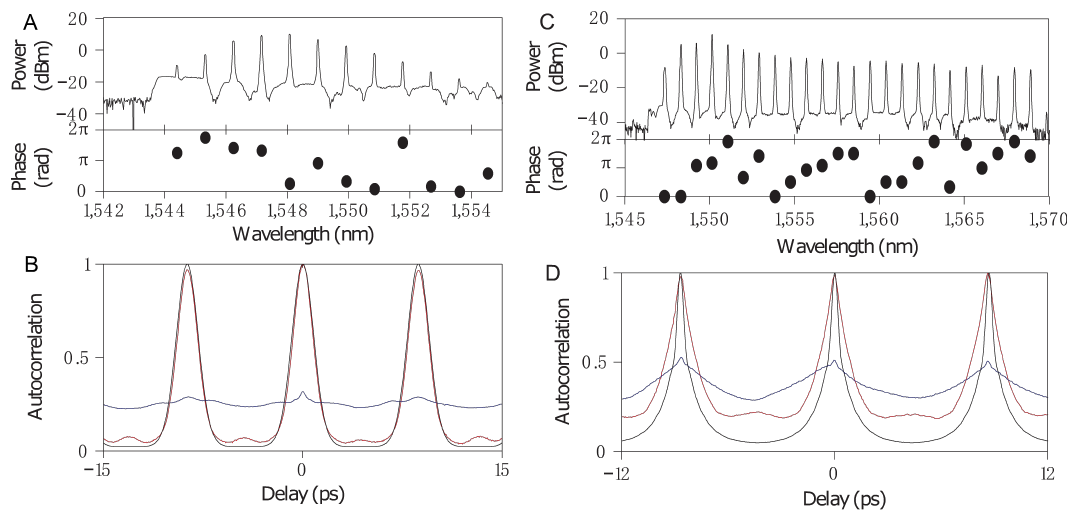
Figure 12: Different compressibility for (A, B) type-I and (C, D) type-II combs. (A), (C) Comb spectra before autocorrelator and phase shifts applied to each comb line by the pulse shaper. (B), (D) Intensity autocorrelation traces. Red: measured after phase compensation; black: calculated by assuming a flat comb spectral phase; blue: measured without phase compensation. Adapted by permission from Macmillan Publishers Ltd: Nature Photonics [31], copyright 2011.